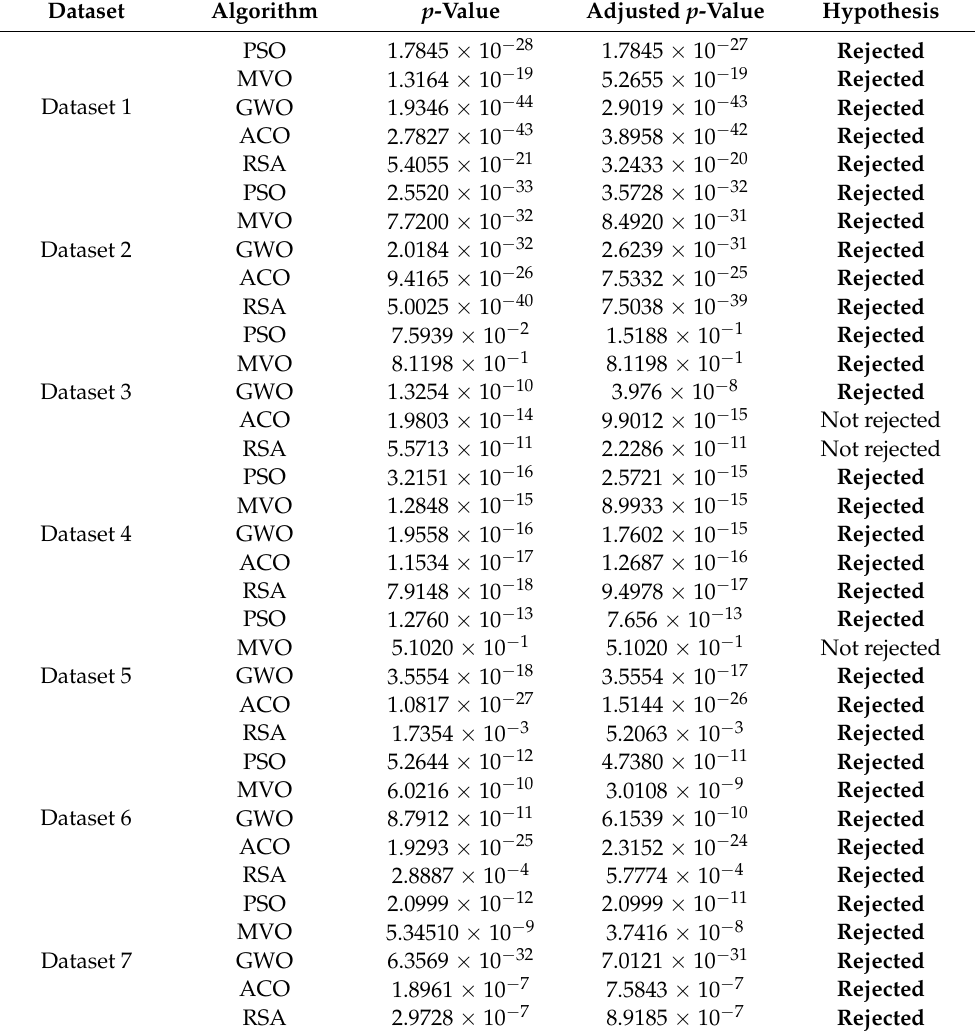
Table 8. Significant tests of the controlled method (ACO-RSA) and other MA using Holm’s